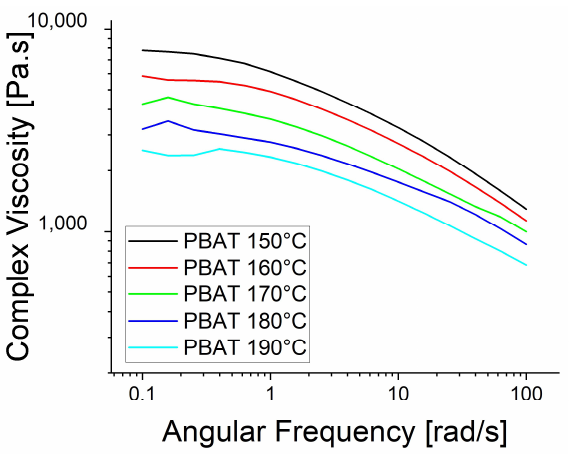
Figure 9. Rheological temperature sweep for PBAT.